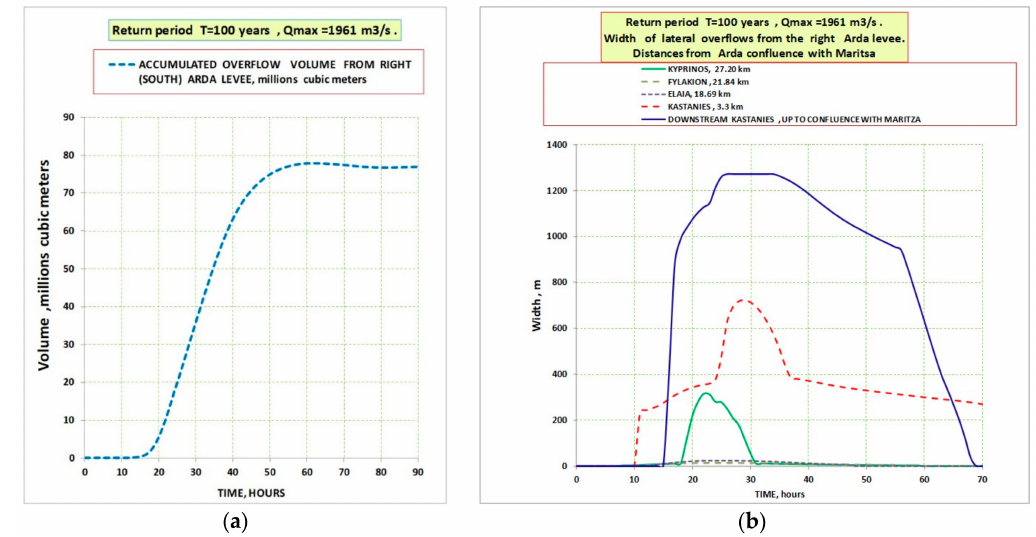
Figure 9. ( a ) Accumulated lateral overflow volume (to storage areas or out of the main Arda) from right (south) Arda levee; ( b ) Width of lateral overflows from the right (south) Arda levee. Distances are measured from the Arda–Evros confluence.